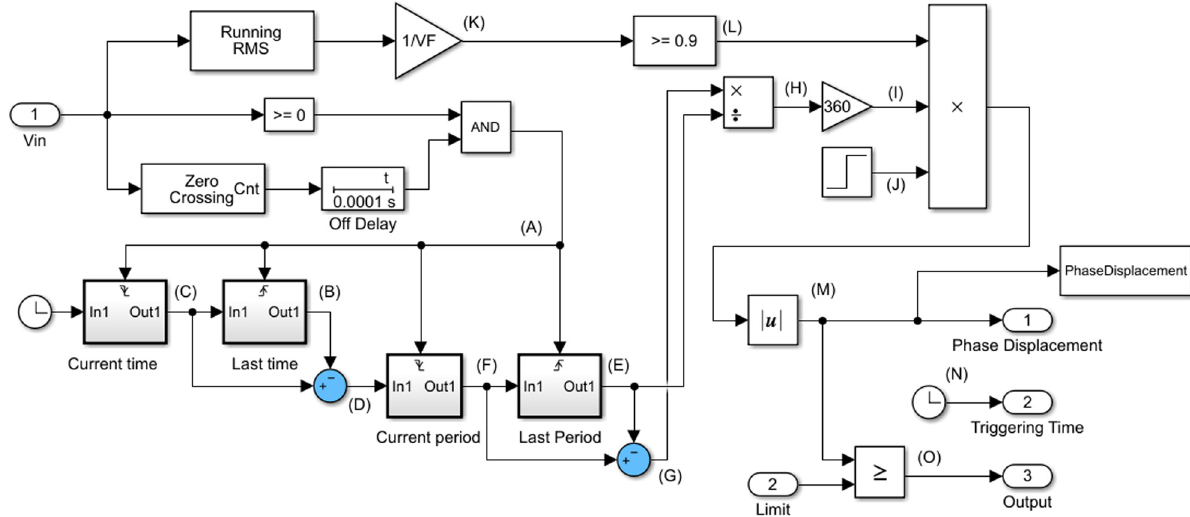
Figure 6: Diagram of the proposed vector shift relay implementation in